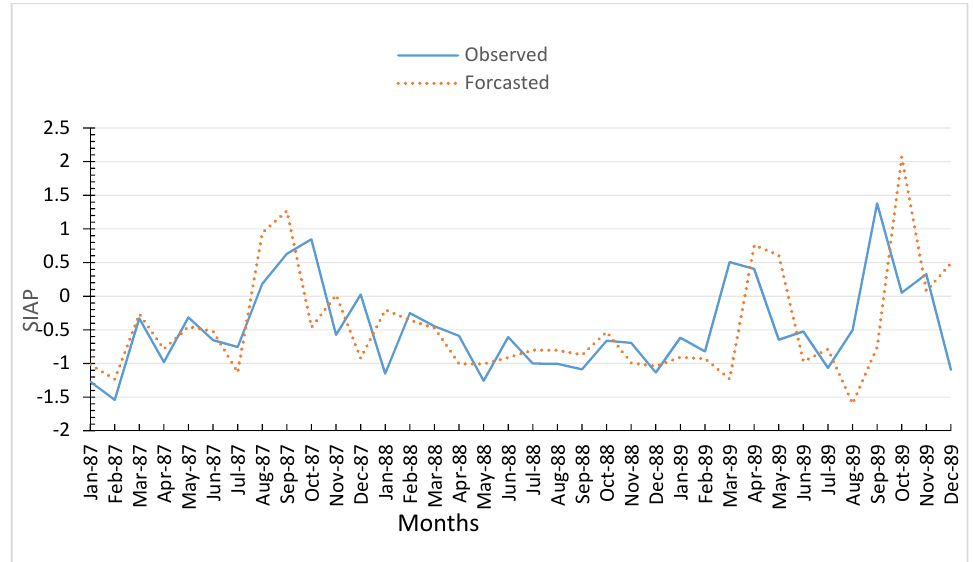
Figure 10. Comparison of observed and forecasted SIAP at station 2 of input model number 1.